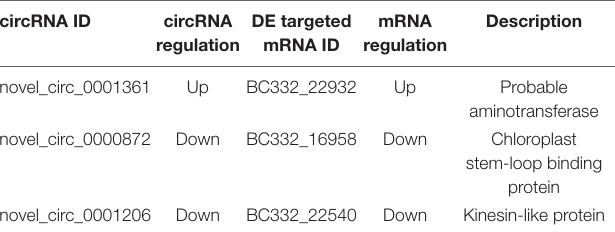
TABLE 4 | The detailed information of DE circRNA and its targeted mRNA.